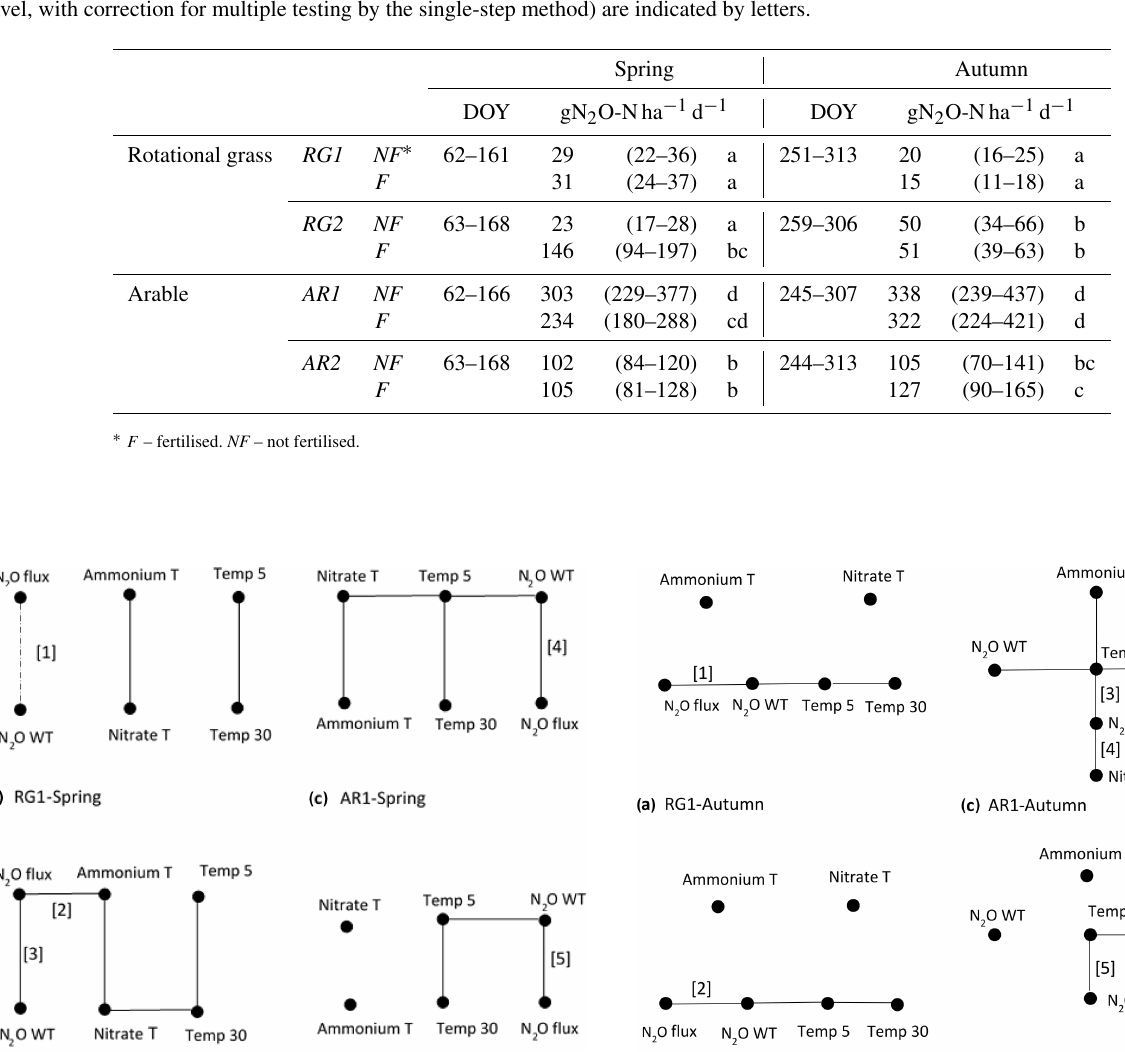
Table 2. Daily emissions of N 2 O during the monitoring periods in spring and autumn were analysed with a generalised linear mixed model (see text). Estimation for each season was performed using the trapezoidal approximation of the integral of the emission curve. Numbers in brackets indicate 95% confidence intervals, and significant differences between all eight treatments within each season (at 5% significance level, with correction for multiple testing by the single-step method) are indicated by letters.